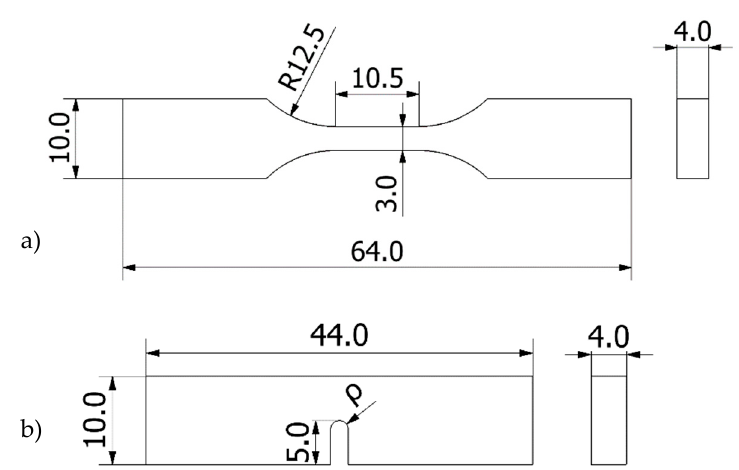
Figure 1. Schematic with the dimensions of the ABS specimens: ( a ) tensile specimens; ( b ) fracture specimens ( ρ varying from 0 mm up to 2 mm. Span = 40 mm). Dimensions in mm.